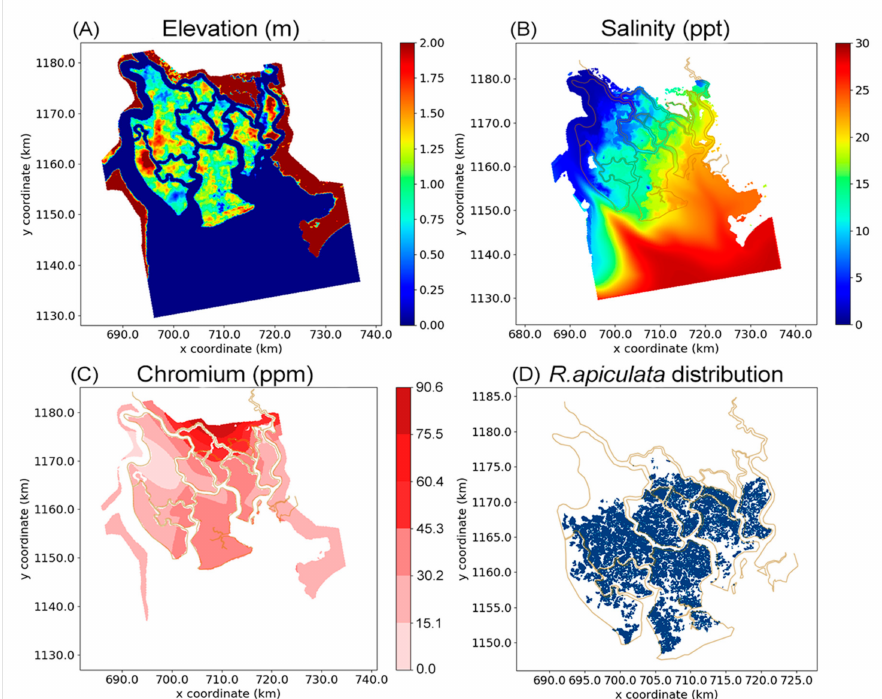
Figure 2. Spatial distribution of input data for the growth model, including an elevation map ( A ), a salinity map ( B ), a Cr content distribution map ( C ), and a map of Rhizophora apiculata forest ( D